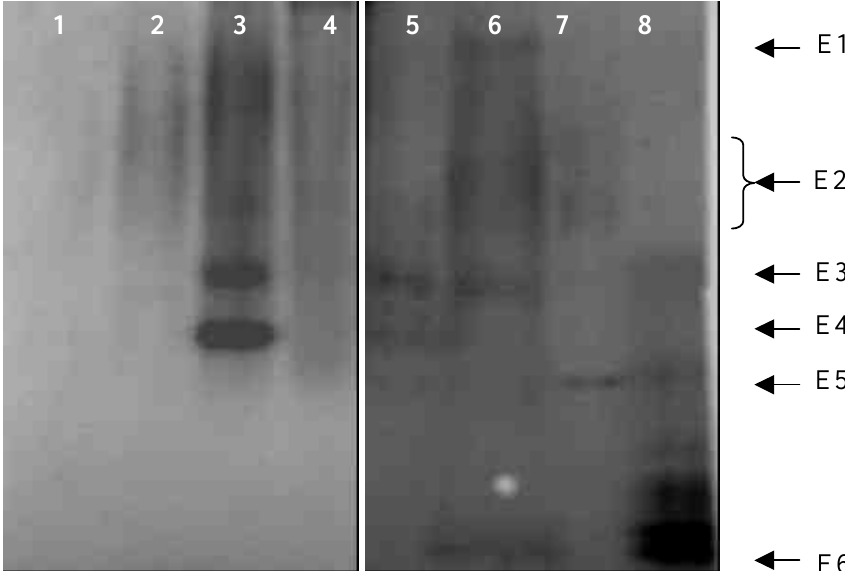
Figure 2. Analysis of esterase isoenzymes from C. eragrostidis by native polyacrylamide gel electrophoresis (PAGE, 7.5%).